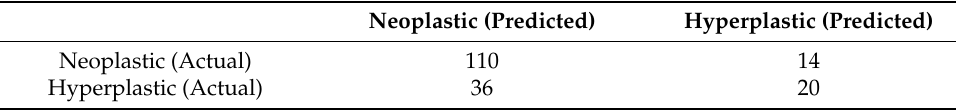
Table 17. Confusion matrix of WL polyp classification.